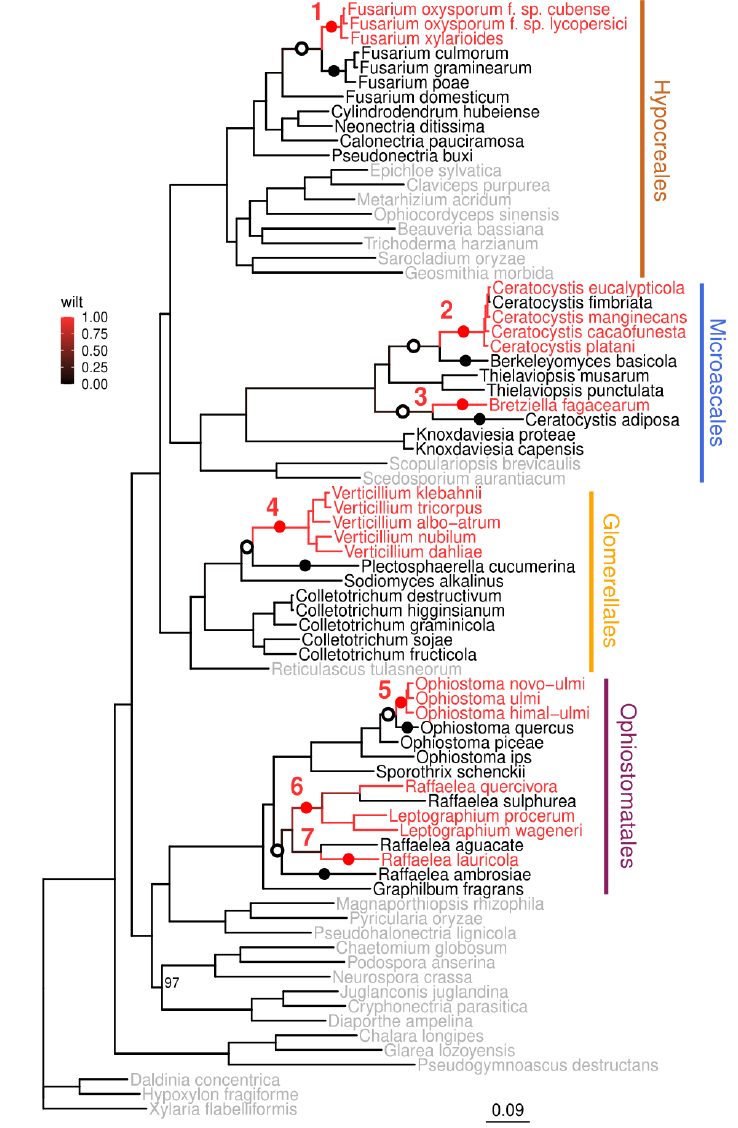
Figure 1. Seven origins of wilt-causing pathogens in Sordariomycetes. Maximum phylogeny in Sordariomycetes based on 3723 conserved single-copy genes calculated with IQ-TREE. Bootstrap support for all nodes is 100, except for one (97) shown on the tree. Species causing wilt are marked with red, species not causing wilt with are marked with black, and species not causing wilt and specifically chosen to support the phylogeny are marked with gray. Branch color corresponds to the scaled likelihood of causing wilt, estimated for all ancestral nodes using ace function from R package ape. Red dots indicate the most recent wilt-causing common ancestor of wilt-causing pathogens, black dots indicate non-wilt-causing species, or the most recent common ancestors of non-wilt-causing species used for comparison, open dots indicate the most recent common ancestor of wilt-causing species inferred as non-wilt-causing species, also used for comparison. Numbers indicate seven most likely transitions from non-wilt to wilt-causing pathogens.